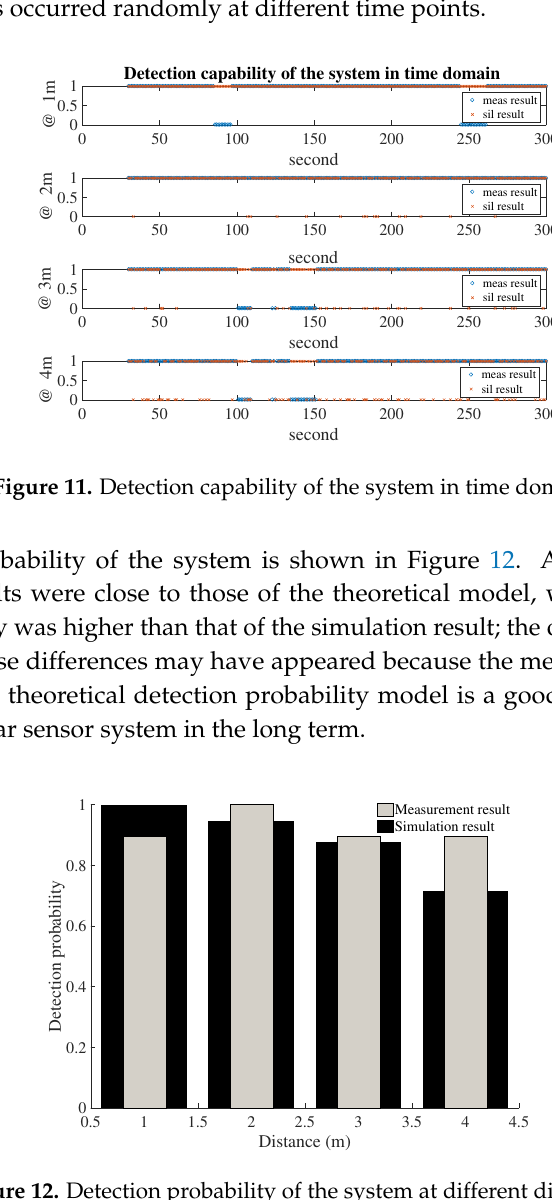
Figure 12. Detection probability of the system at different